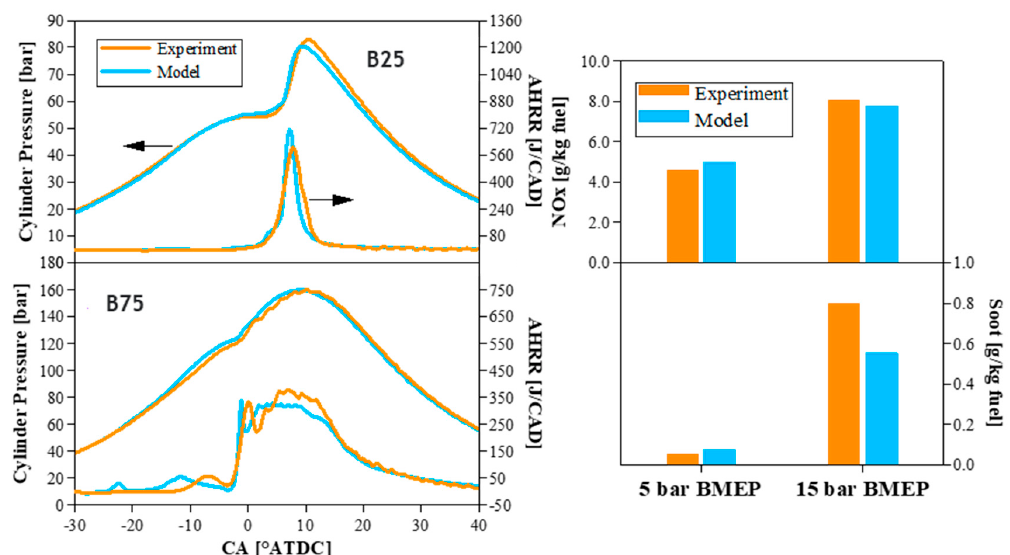
Figure 4. Comparison of cylinder pressure, apparent heat release rate (AHRR), and emissions between the experiments and model results at B25 and B75.